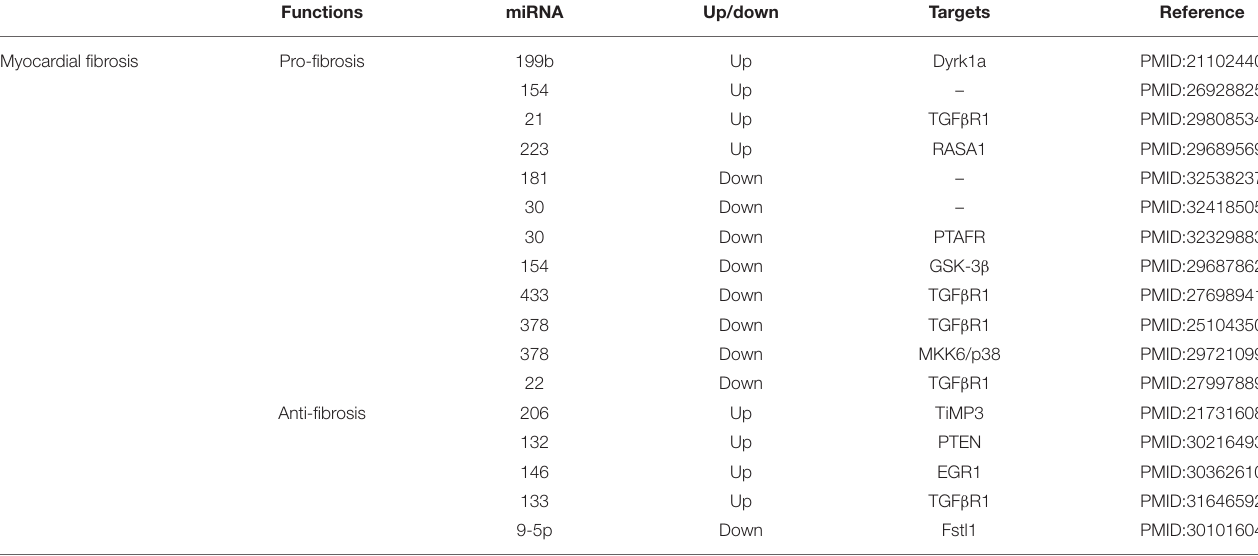
TABLE 2 | Micro RNAs targets and functions in myocardial